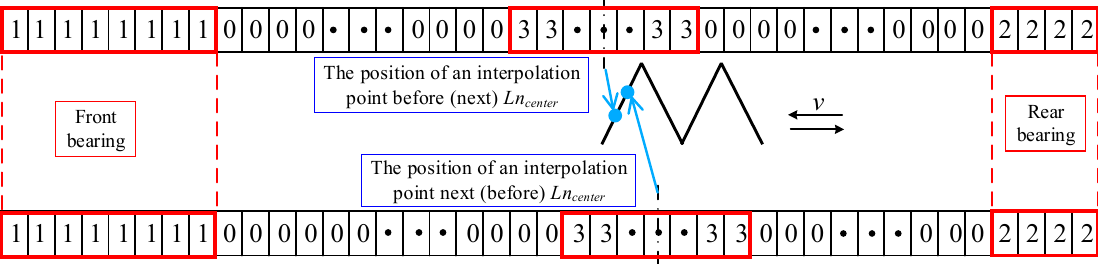
Figure 7. Schematic diagram of applying nut moving heat source.